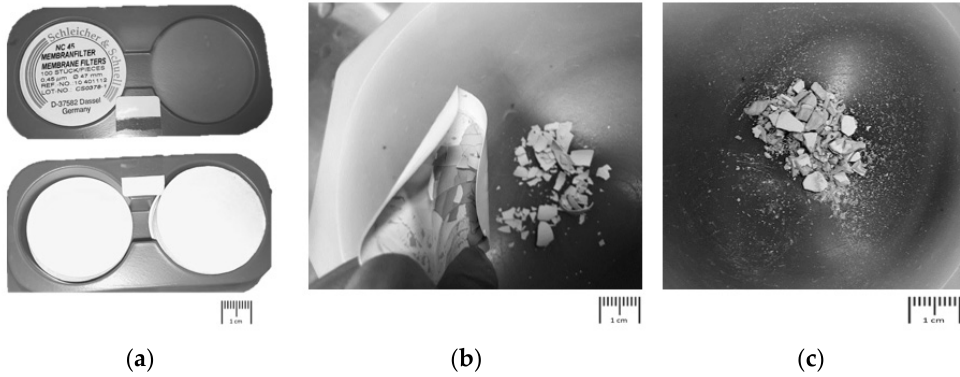
Figure 2. Vacuum-driven membrane filter. ( a ) Schleicher and Schell filter. ( b ) Dried particles in the filter. ( c ) Separation of the particles in the agate mortar.